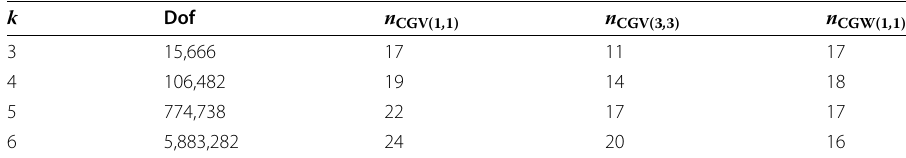
Table 4 Measured iteration numbers n CG for the preconditioned CG method attained for the model problem (20) on the configuration depicted in Fig. 5 using a single element